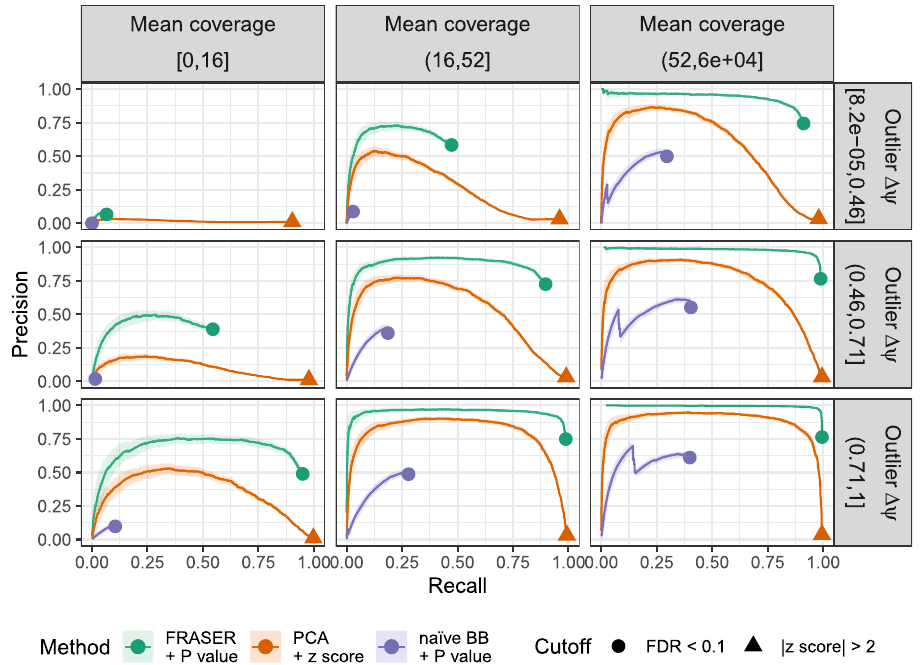
Fig. 4 Benchmark using arti fi cially injected outliers for alternative acceptor usage. The proportion of simulated outliers among reported outliers (precision) plotted against the proportion of reported simulated outliers among all simulated outliers (recall) for increasing P values (FRASER, green; naïve beta-binomial regression, purple) or decreasing absolute z scores (PCA, orange). Moreover, all events with j Δ ψ strati fi ed by the mean coverage of the intron (columns) and by the injected absolute Δ ψ 5 value (rows). The cutoffs for each method are marked (FDR < 0.1, circle; absolute z score > 2, triangle). The darker lines mark the precision-recall curves computed for the full dataset while the light ribbons around the curves indicate 95% con fi dence bands estimated by bootstrapping ( n = 200). These results show the importance of controlling for latent confounders, of using a count-based distribution, and of correcting for multiple testing. BB beta-binomial, FDR false discovery rate, PCA principal component Fig. S14). Dirichlet-Multinomial-based approaches might be improved using latent space fi tting, but this is not yet supported by existing implementations.